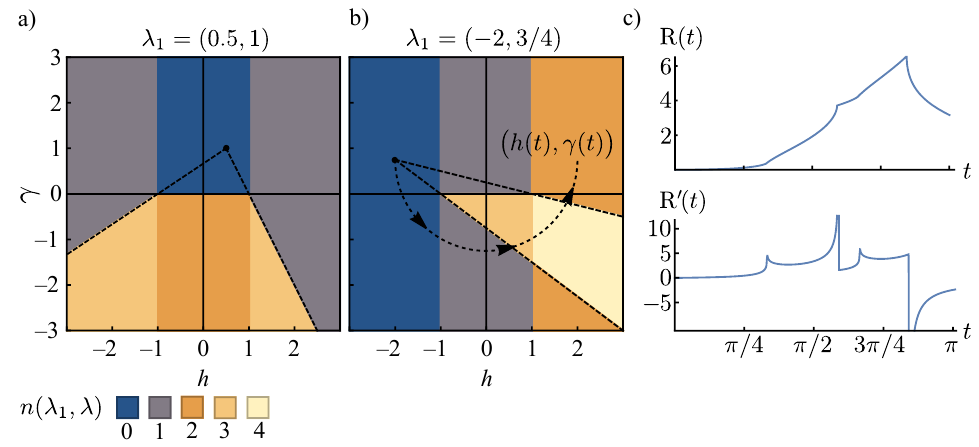
Figure 3: a) and b) The Loschmidt index n ( λ